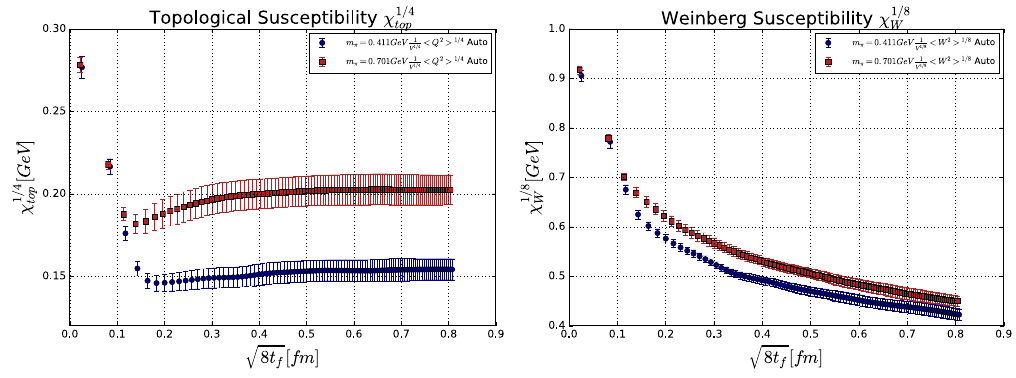
Figure 1. Topological (left) and Weinberg (right) susceptibilities in GeV, plotted against the flow-time radius 8 t f . Blue and red points are the m π = 411 , 701 MeV results respectively. Errors were estimated using the autocorrelation analysis technique described in [14]. (cid:31)